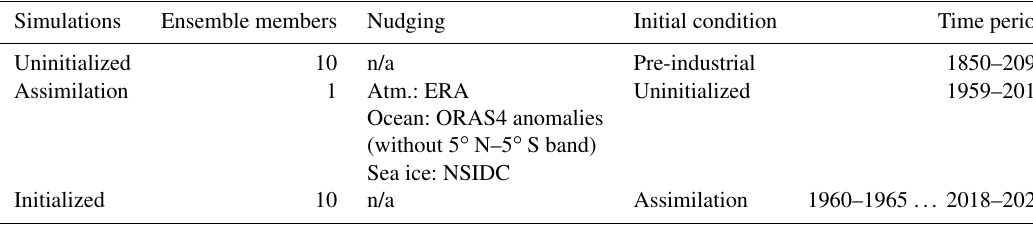
Table A1. Simulations based on MPI-ESM1.2-LR. The resolution for the atmosphere is T63L47 and for the ocean is GR15L40. The design of the prediction simulations is according to previous studies (Marotzke et al., 2016; Li et al., 2019). The assimilation starts from the end of the year 1958 in an uninitialized simulation. The nudging is strong; therefore, assimilation starting from a different uninitialized simulation would end up with similar evolution of the climate and carbon cycle. Figure 1 illustrates the simulations with evolution of atmospheric CO 2 growth rate together with observations. The initialized simulations start from the assimilation yearly from October 31st and run freely for 2 months plus 5 years afterwards. We have 59 runs for each ensemble of initialized simulations starting from 1960 to 2018 annually, and these run for 5 years and 2 months each, i.e., November 1960–December 1965 for starting year 1960, November 1961–December 1966 for starting year 1961, and so forth until November 2018–December 2023. The ensembles are generated with lagged 1d initialization, i.e., the simulations start from 10 consecutive days from 31 October to 9 November. The ensembles for uninitialized simulations (shown as in Fig. A3) are generated by starting from different years of the control simulation (Fig.